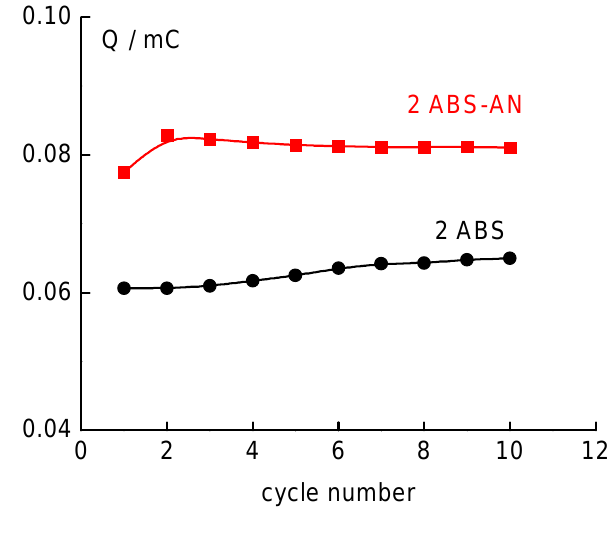
Figure 2. Dependence of the cathodic charge on the cycle number of SPAN